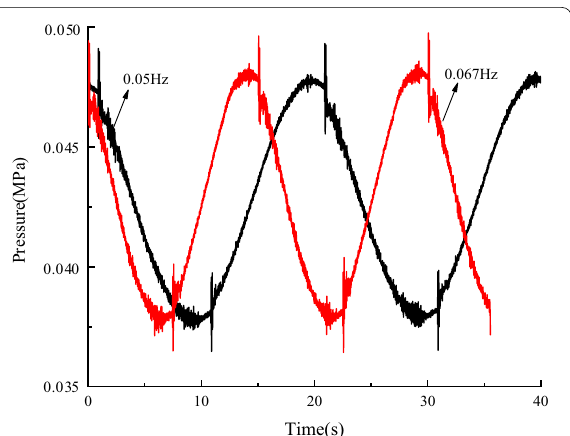
Figure 30 Changes in pressure at different frequencies